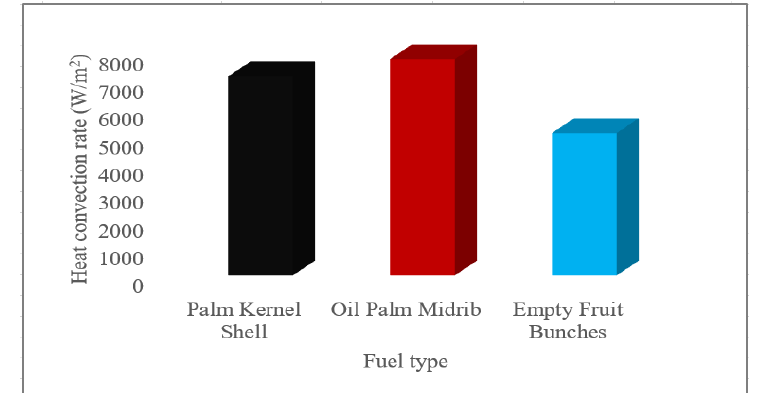
Figure 12. Heat transfer coefficient for a different fuel.